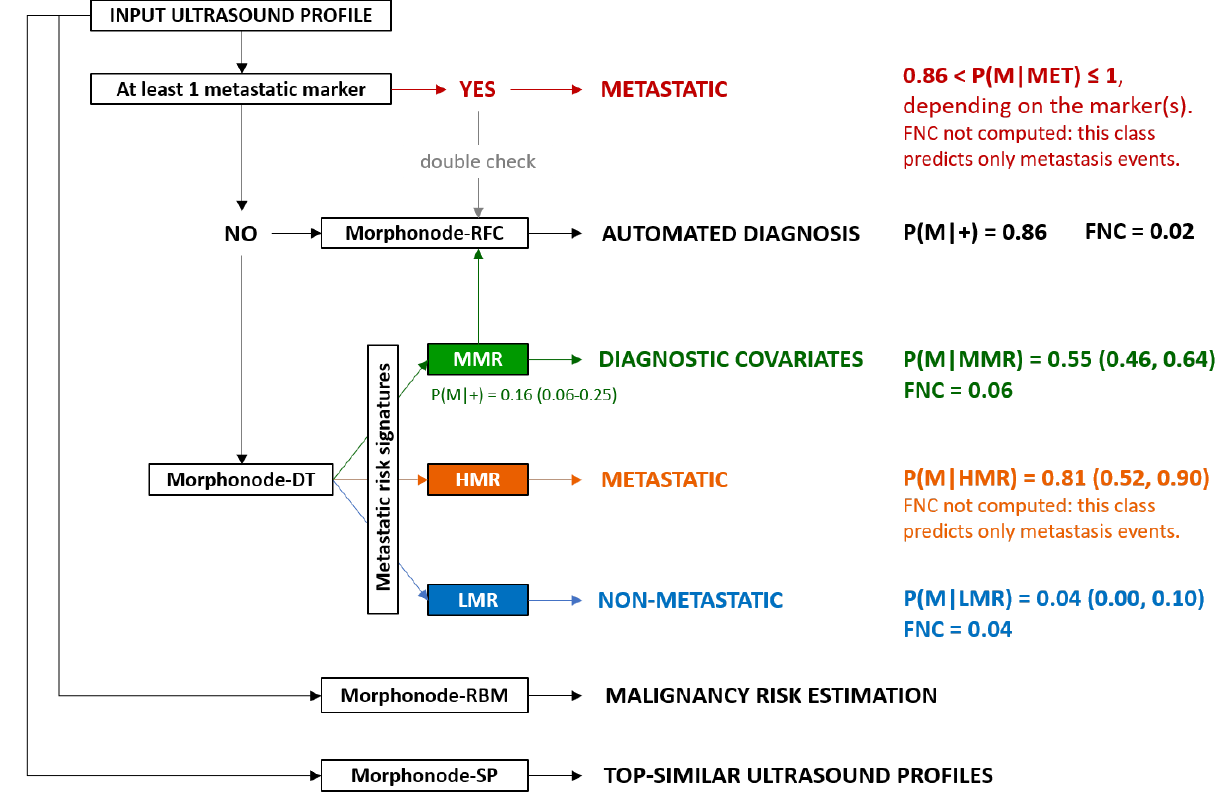
Figure 8. Morphonode Predictive Model workflow.